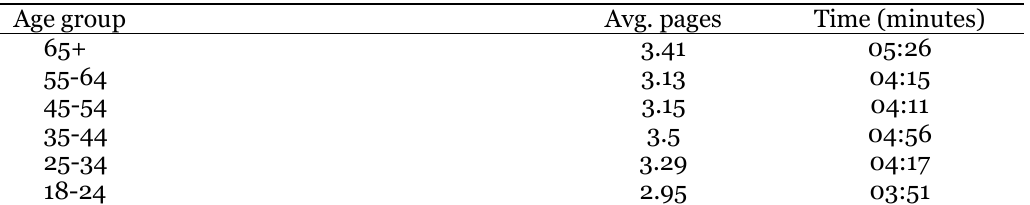
Average Pages and Time Different Users View/ Spend on Each